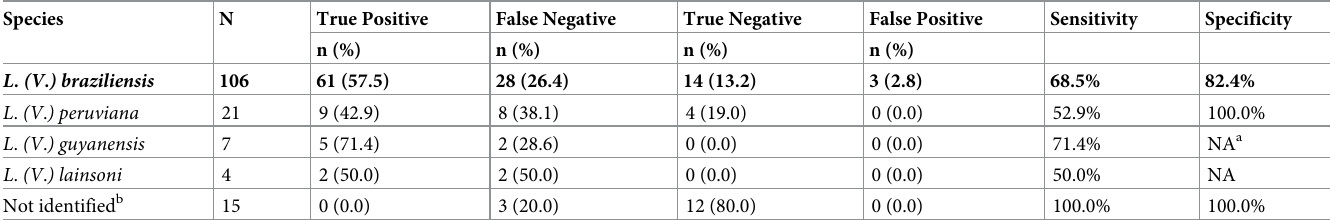
Table 4. Modified CL Detect Rapid Test Sensitivity and Specificity by Species of Samples Collected with Dental Broach–All Subjects.